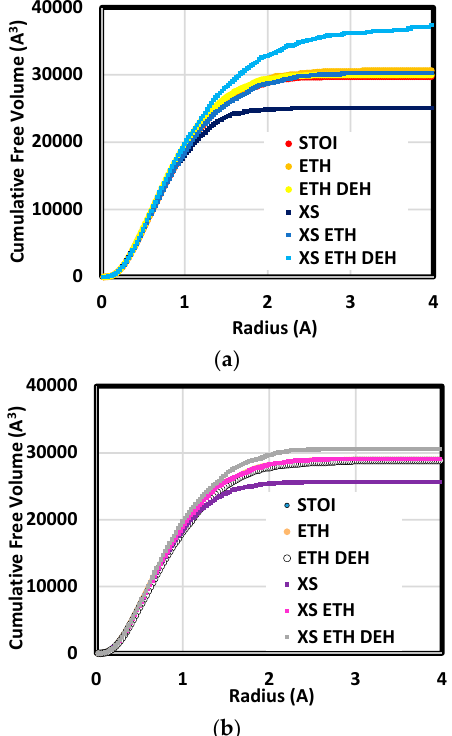
Figure 9. Cumulative free volume distributions for short ( a ) and long ( b ) chain systems.